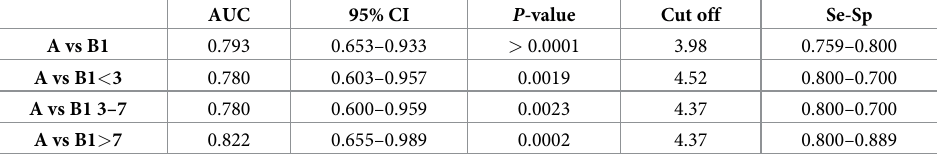
AUC = area under the ROC curve; CI = confidence interval; Se = sensitivity; Sp =